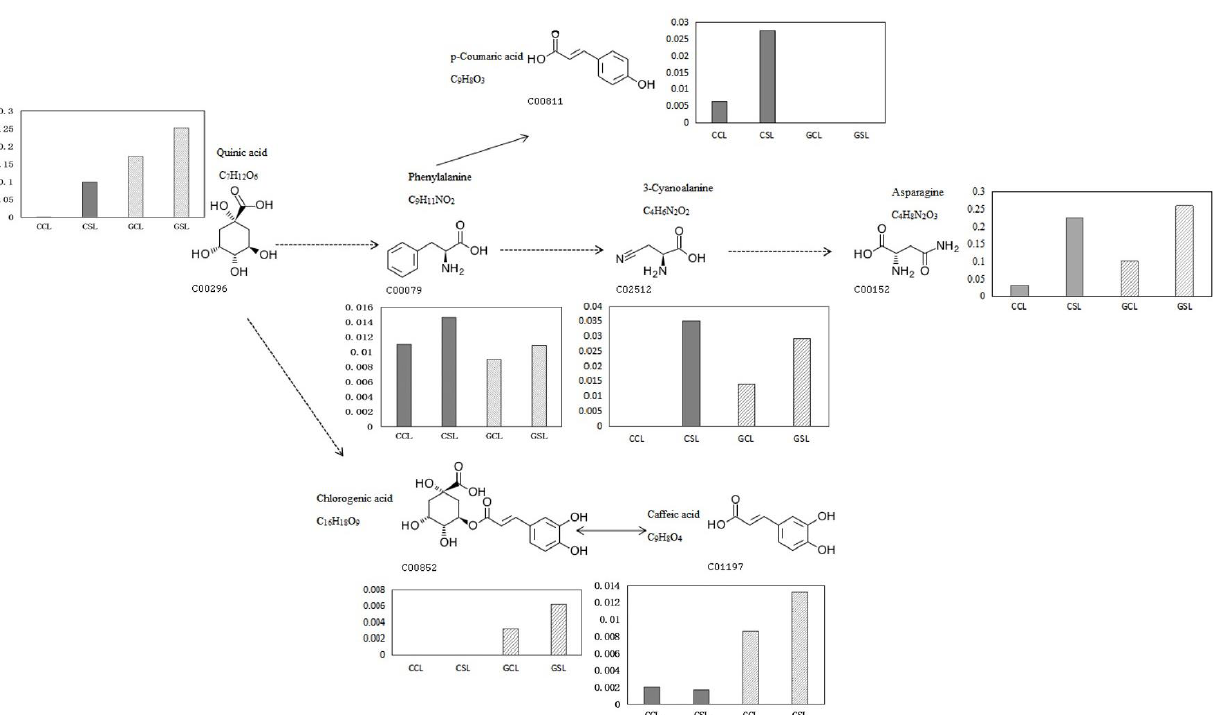
Figure 5. The pathway diagram of key drought-responsive metabolites from two cherry rootstocks. Solid arrows indicate direct reactions between metabolites. Dashed arrows indicate indirect reactions between metabolites. CCL and CSL represent control and drought treatment samples of CDR-1. GCL and GSL represent control and drought treatment samples of Gisela 5. Because the relative content of substances was detected by nontarget GC-MS, there are no units.